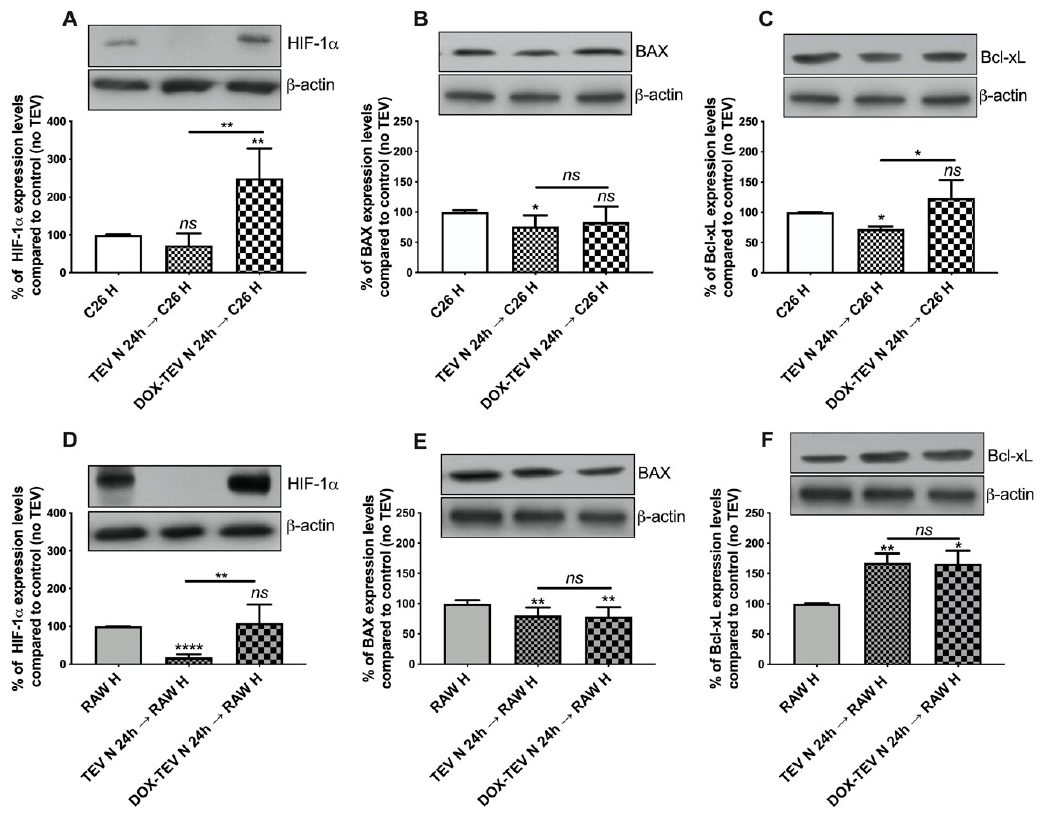
Figure 8. Overview on the molecular changes determined by TEV and DOX-TEV pretreatment on the recipient hypoxic C26 and RAW 264.6 cells exposed to DOX treatment. Cropped Western blot images and their representative graphs displaying the percentage of protein levels after hypoxic C26 and RAW 264.7 cell pretreatment for 24 h with C26 normoxic TEV (N TEV) or DOX-TEV (N DOX TEV) under hypoxic conditions, followed by treatment with 0.75 µ M DOX under hypoxia for 24 h, as compared to controls (the levels of the same proteins in hypoxic cells treated with 0.75 µ M, but no TEV pretreatment), which are shown for HIF-1 α ( A , D ), for BAX ( B , E ), and for Bcl-xL ( C , F ). Data were expressed mean ± SD of triplicate measurements from two independent experiments. Unpaired t -test was used for statistical analysis of the data; ns : not significant, p > 0.05; *, p < 0.05, **, p < 0.01, ****, p < 0.0001.